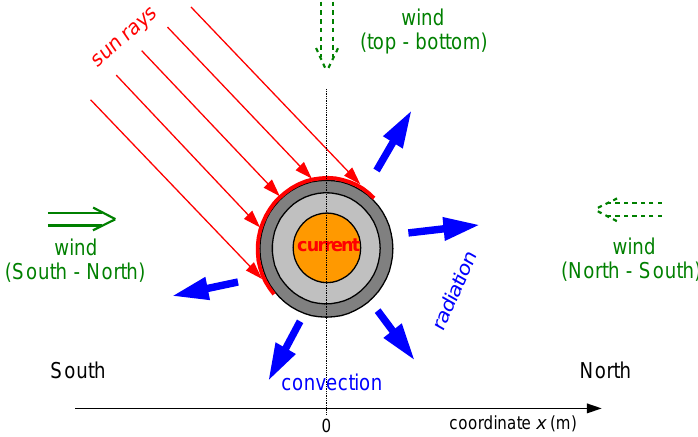
Figure 2. Simplified geometry of the power cable heating/cooling model.